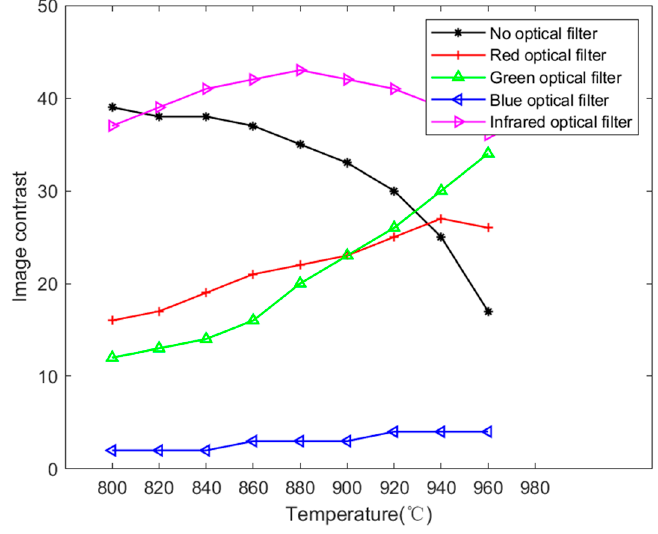
Figure 5. Image contrast results with different optical filters and different temperatures.